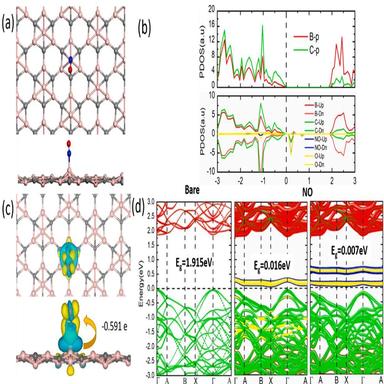
(a) Top and side views of the NO adsorbed electronic structure. (b) The density of state before and after the adsorption. (c) The differential Charge density of NO/B4C3 configuration. (d) Band structure of pristine and NO-adsorbed B4C3.